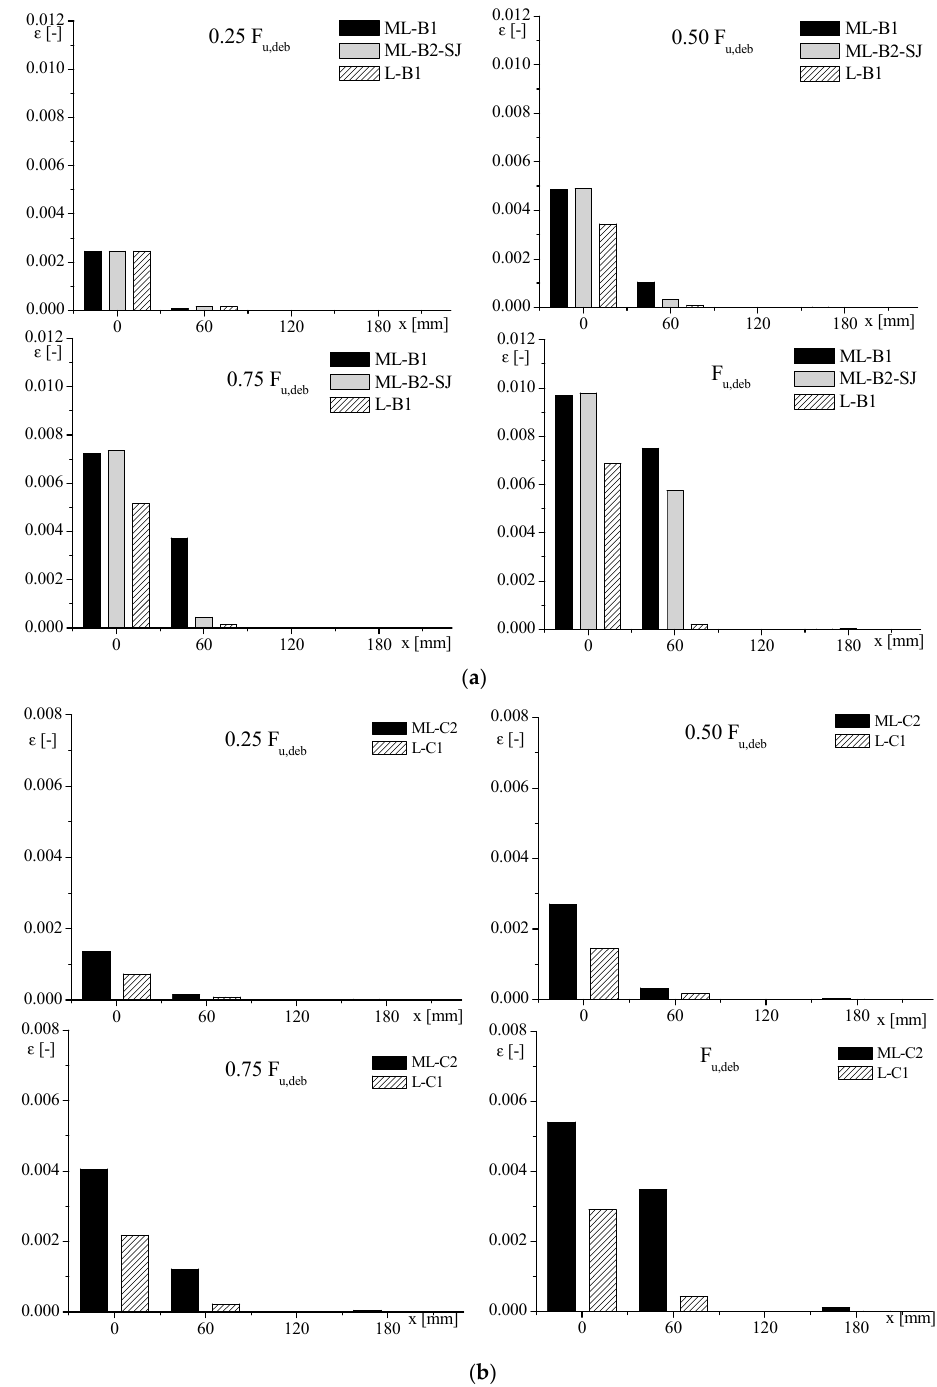
Figure 14. Strain–position values of stone unit and stone masonry unit substrate with ( a ) BFRP-1 and -2; ( b ) CFRP-1 and -2.